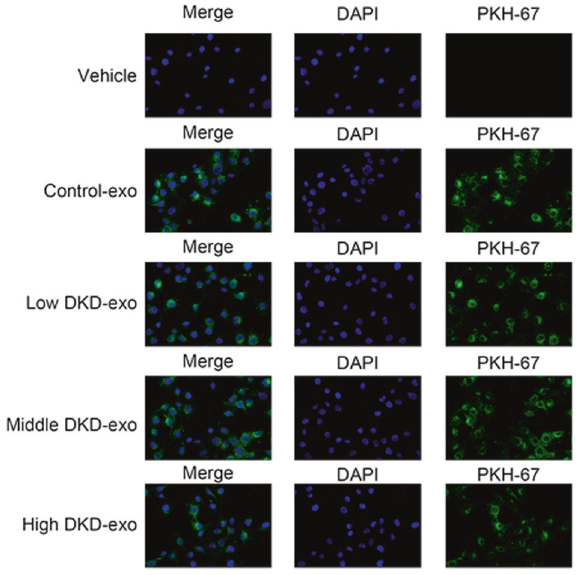
Fig. 2 Human kidney cells uptake exosomes from patients with DKD. A Exosomes from patients with DKD were incubated with PKH- 67 and HK-2 cells were treated with these exosomes. Uptake of exosomes by HK-2 cells was visualized with confocal